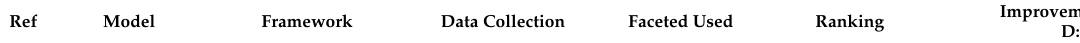
Table 3. Comparison of existing facet graphical